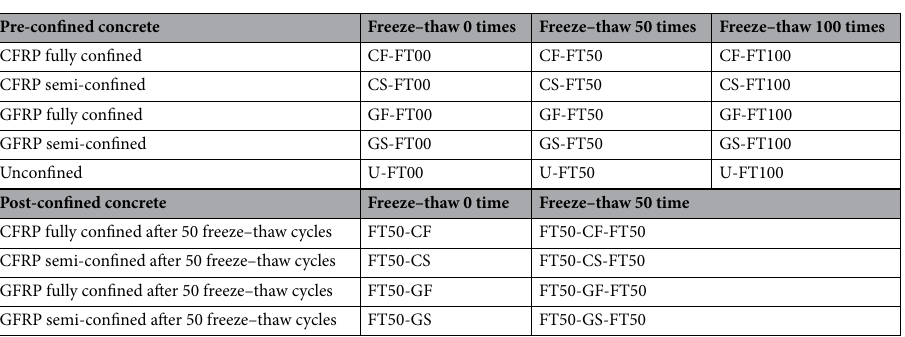
Table 3. Concrete column specimen number. ‘G’ means that the sample is made of GFRP material; ‘C’ means that the sample is made of CFRP material; ‘U’ means that the sample is unconfined; ‘F’ means